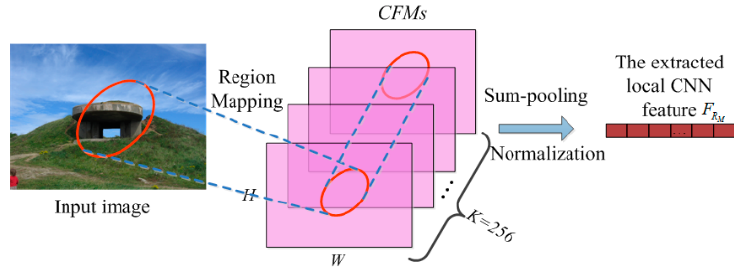
Figure 4. The illustration of local CNN feature extraction.